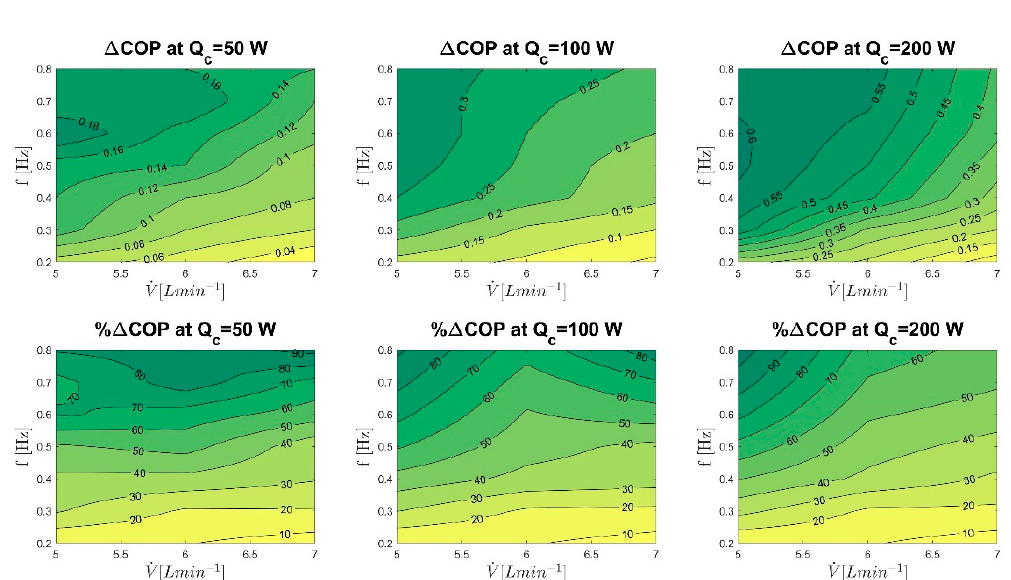
Figure 16. ‘8MAG’ COP changing by reducing ECL on the MCW for different operating conditions at T H = 22 °C. Temperature spans are in the range between 1 K and 8.5 K.